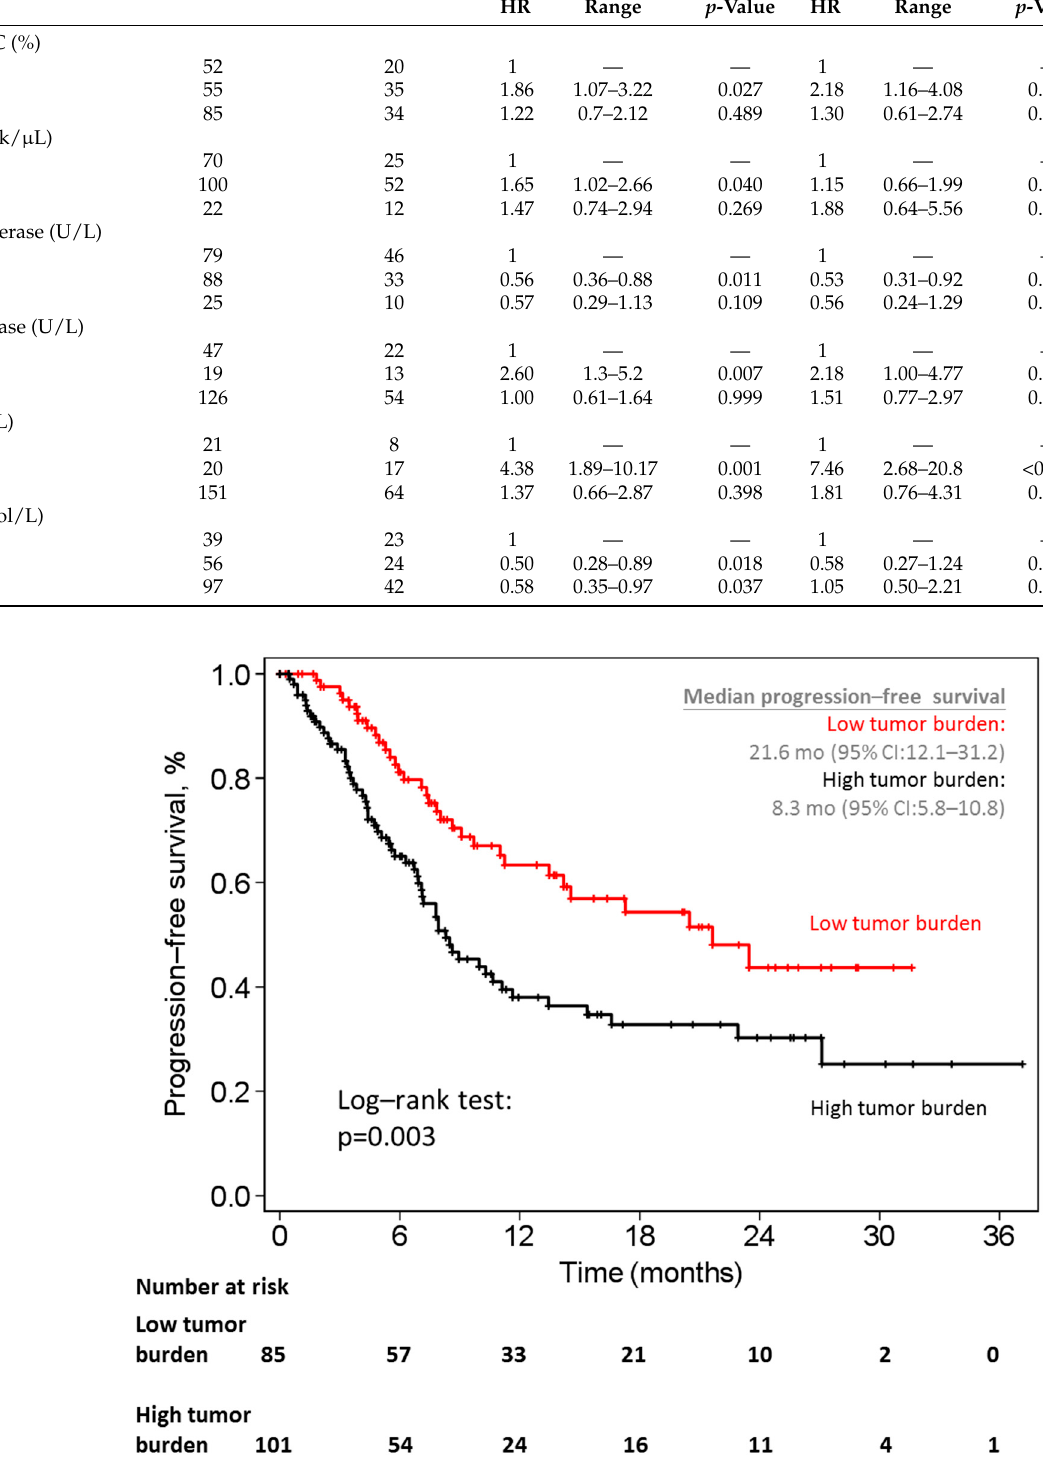
Figure 4. Kaplan–Meier curves of progression-free survival between patients with high tumor burden and low tumor burden. mo = months; CI = confidence interval.